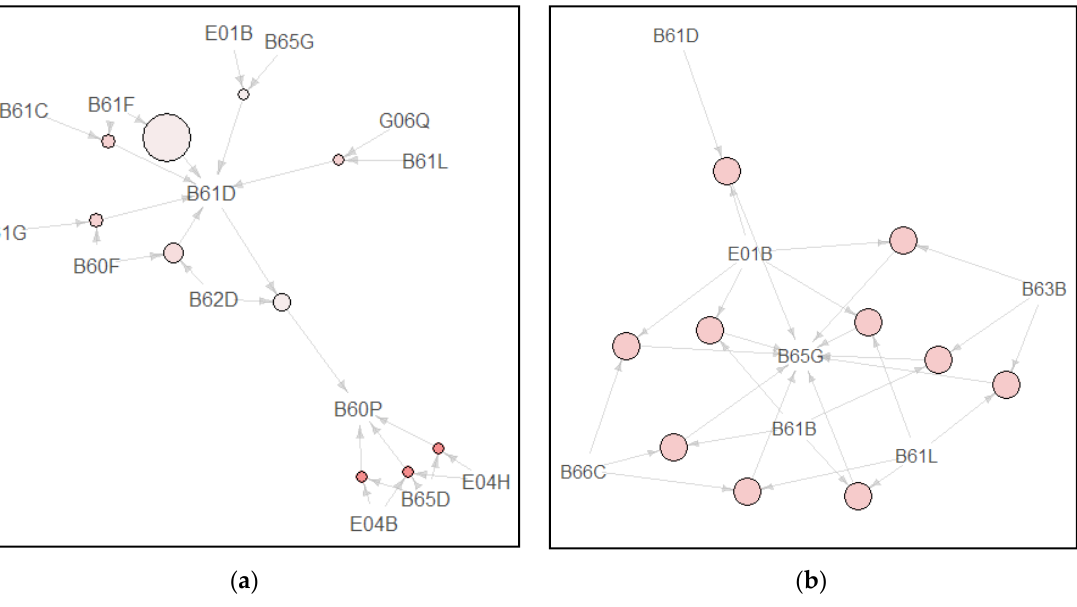
Figure 7. Results of the IPC network analysis: ( a ) 9th patent vacuum and ( b ) 10th patent vacuum. The IPCs that belong to the 9th patent vacuum are B60P and B61D. The technical